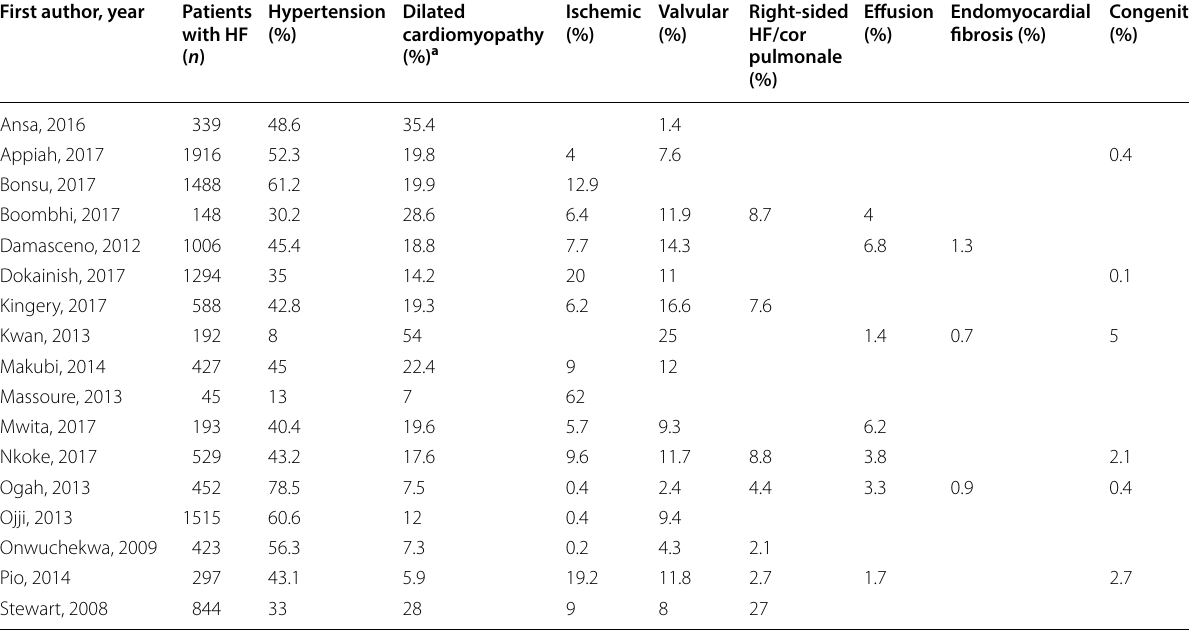
Table 2 Etiology of heart failure in sub-Saharan Africa